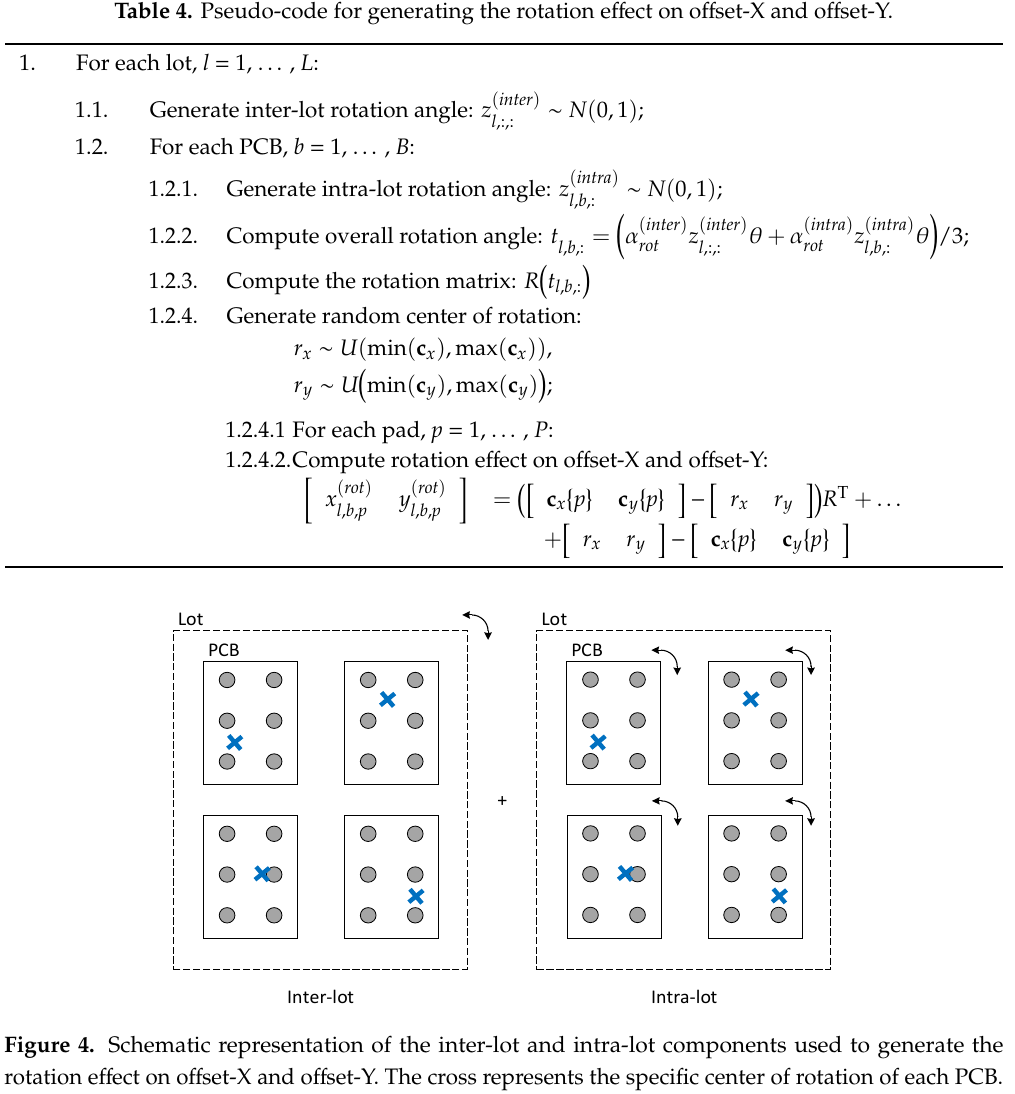
Table 4. Pseudo-code for generating the rotation e ff ect on o ff set-X and o ff set-Y.